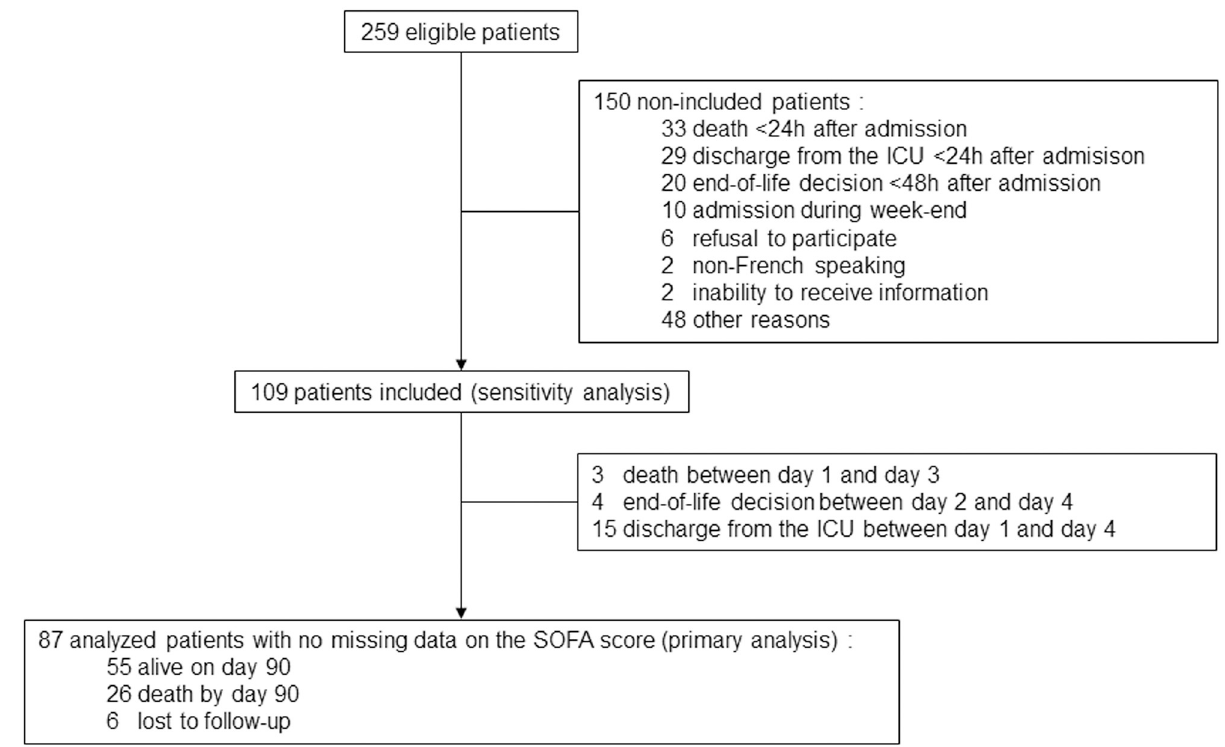
Fig 1. Study flow diagram of